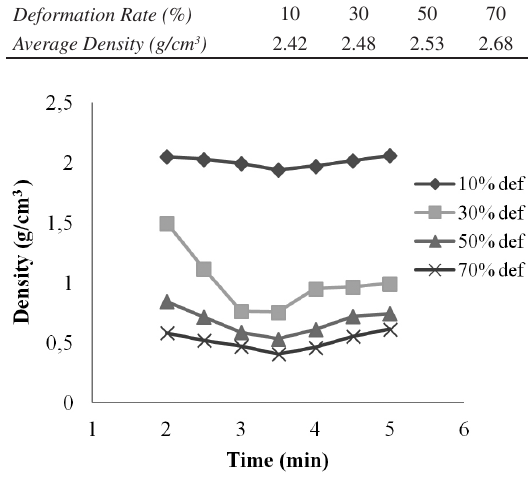
Figure 8. Density of samples foamed at 690